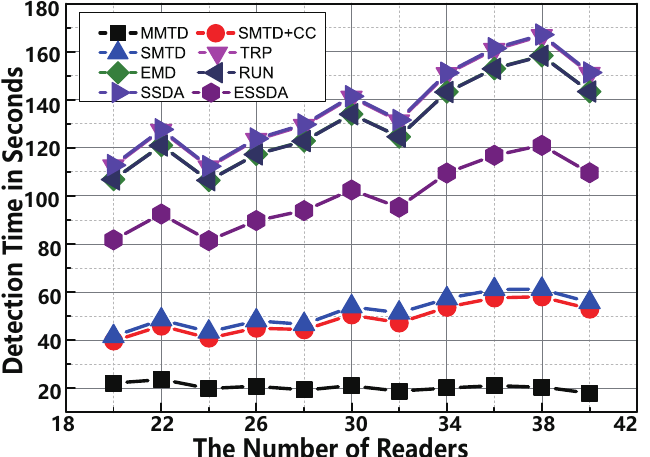
Figure 6. The comparison of time-efficiency between MMTD and other missing tag detection proto- cols when the number of readers R is set to be from 20 to